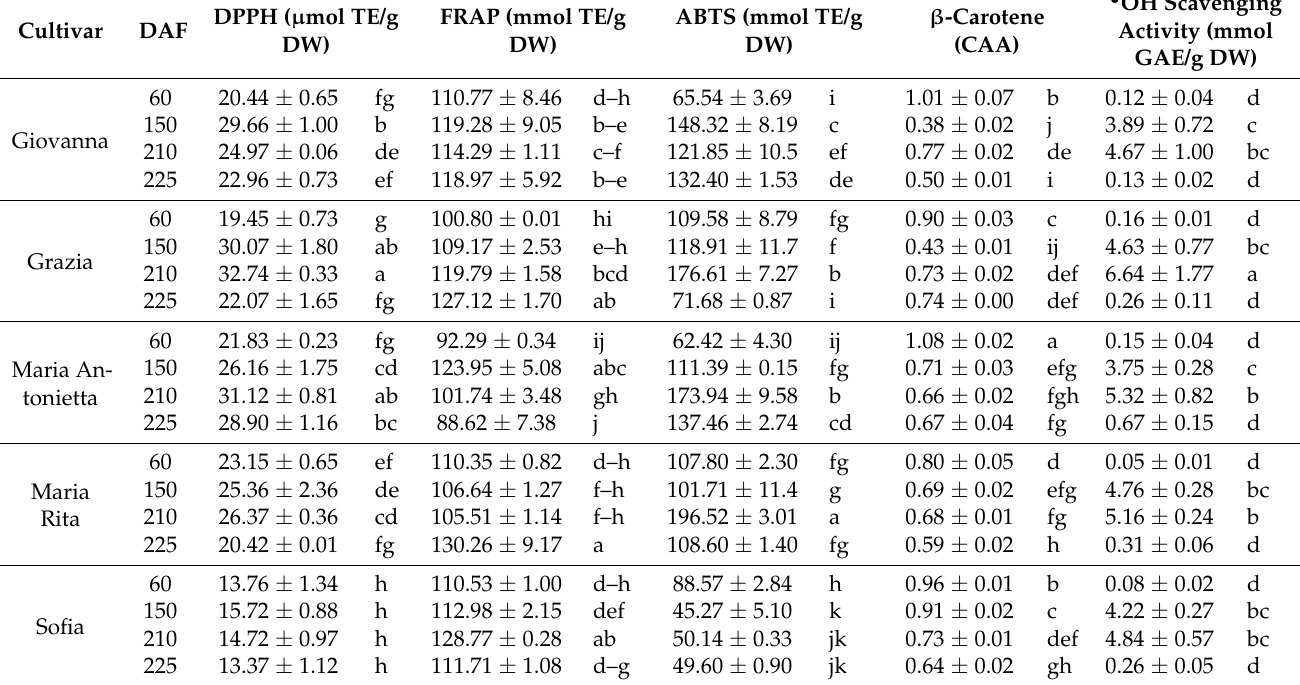
Table 6. Antioxidant activity (AA) in berries of myrtle cultivars evaluated by DPPH, FRAP, ABTS, β -Carotene, and EPR assays. Data are the mean and standard deviation of three replicates. Values in the same column labelled with the same letters are not significantly different according to Duncan’s Multiple Range Test at p ≤ 0.01